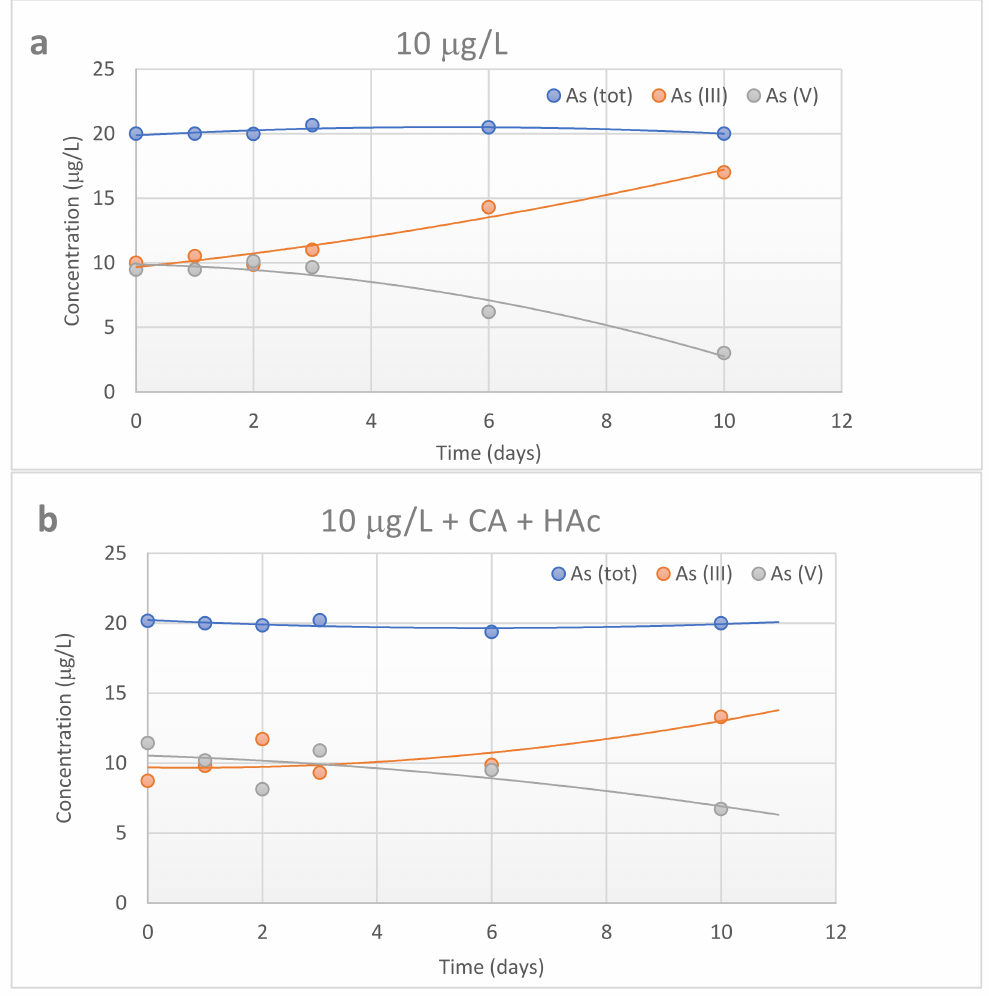
Figure 3. Graphs show the stability of the model solutions in ( a ) double-distilled water with- out preservatives and ( b ) with CA/HAc as a preservative. γ (As(III)) = γ (As(V)) = 10 µ g L − 1 , γ (As (tot)) = 20 µ g L − 1